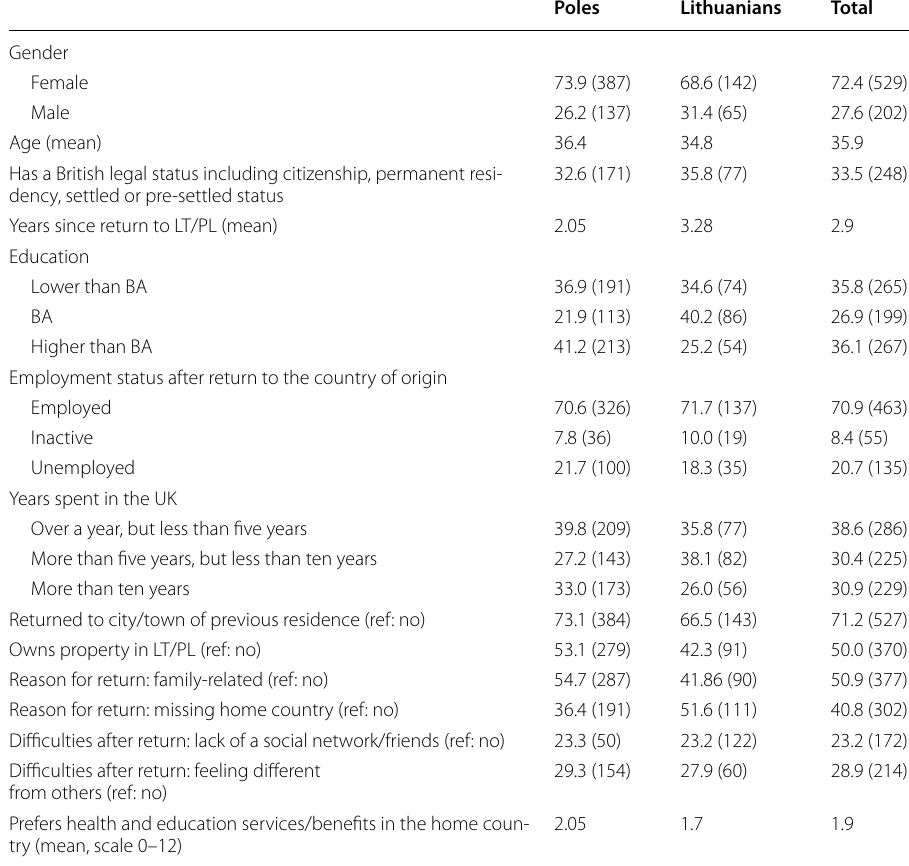
740)—descriptive = Poles